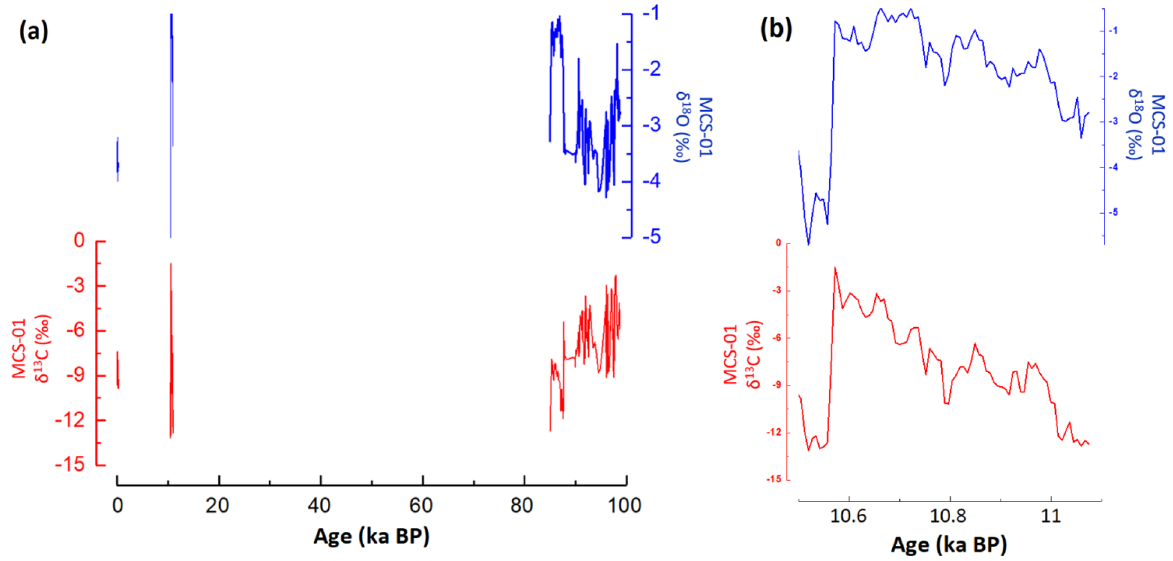
Figure 4. The MCS-01 speleothem isotope (δ 18 O and δ 13 C) records from Majaguas Upper cave in Western Cuba ( a ); the early Holocene record of stalagmite MCS-01 is shown as well ( b